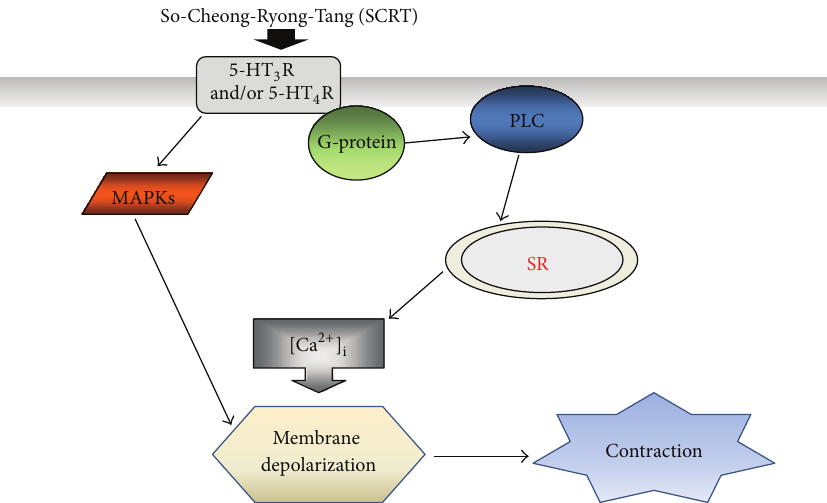
Figure 7: Hypothetical schematic signaling pathway of SCRT-induced membrane depolarizations on ICCs. SCRT-induced membrane depolarization seems to be mediated by 5-HT 3 and/or 5-HT 4 receptor, coupled to G protein, resulting in the activation of PLC pathway, which subsequently increases the intracellular Ca 2+ level from SR. The data also suggest that MAPKs are involved in the SCRT-induced membrane